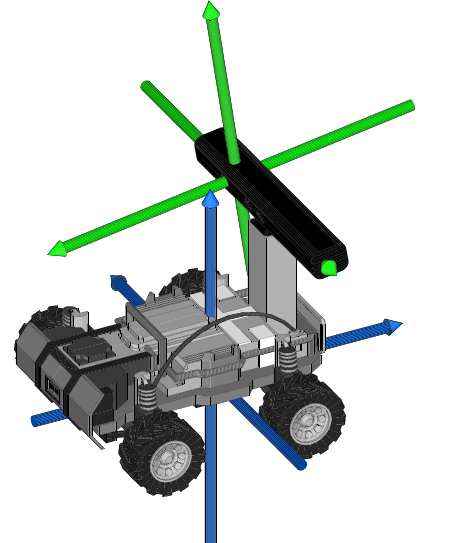
Figure 4. The camera coordinate system (green) and the car coordinate system (blue) [11,